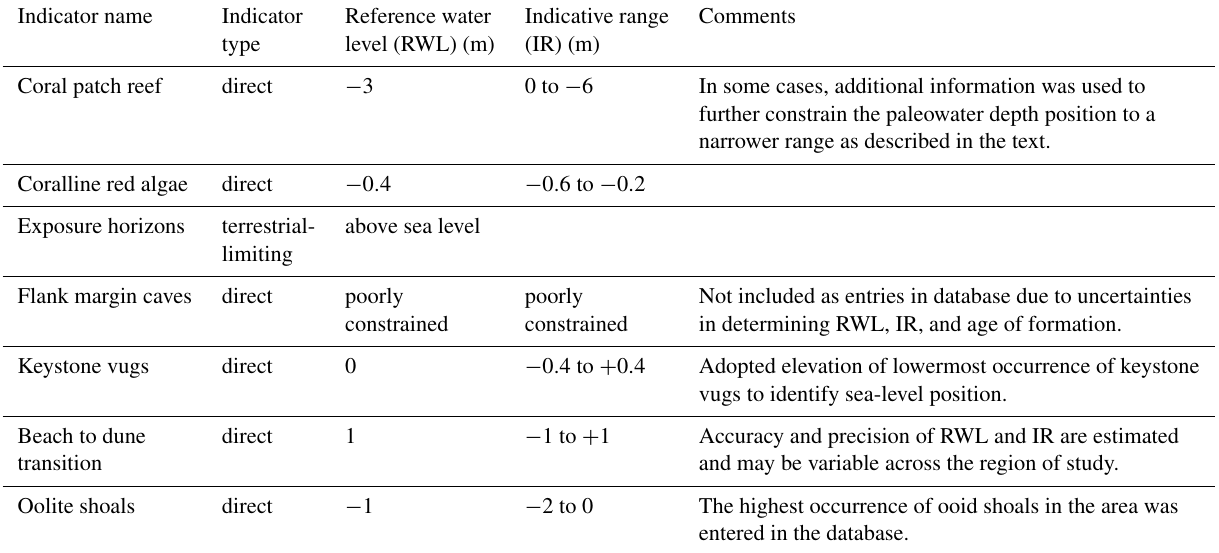
Table 3. Indicator types included in this compilation (see text for detailed